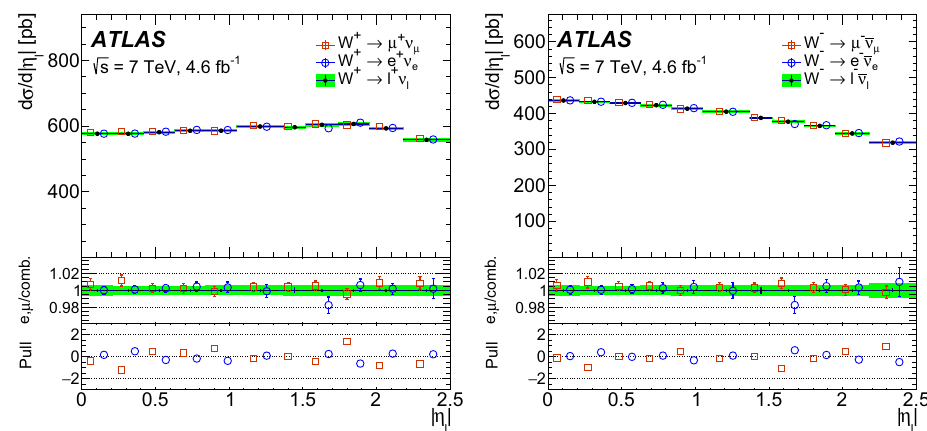
error ( green band ). Also shown are the ratios of the e and μ measure- ments to the combination and the pulls of the individual measurements in terms of their uncorrelated uncertainties, see text